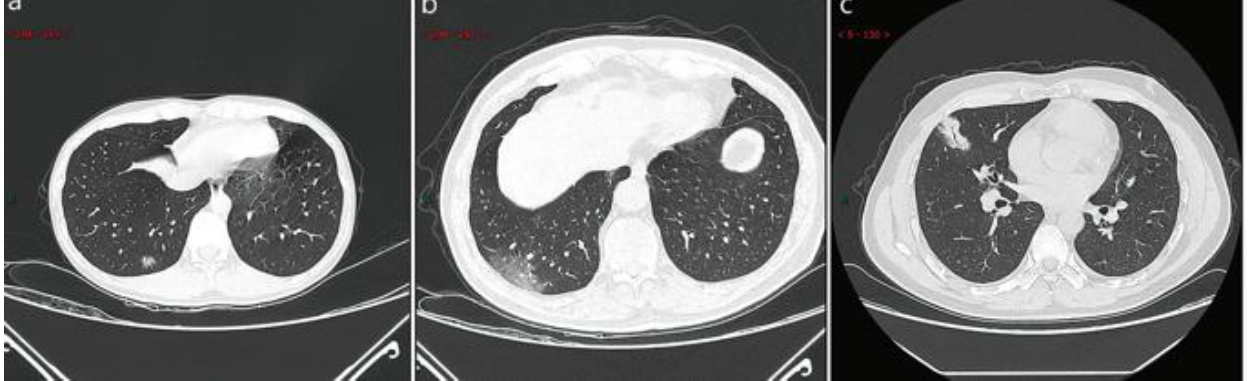
Figure 6: CT imaging of ultra-early stage. a A 33 years old female with patchy ground-glass opacities after occupational exposure. b A 67 years old male with a history of contact with infected patients, showing large ground-glass opacity. c A 35 years old female exhibiting large consolidated opacity with air-bronchogram inside after occupational Early stage . This stage refers to the period of 1– 3 days after clinical manifestations (fever, cough, dry cough, etc.). The pathological process during this stage is dilatation and congestion of alveolar septal capillary, exudation of fluid in alveolar cavity and interlobular interstitial edema. It showed that single or multiple scattered patchy or agglomerated ground-glass opacities, separated by honeycomb-like or grid-like thickened of interlobular septa (Figure 7: 45 cases, 54.2% in a total of 83 cases).